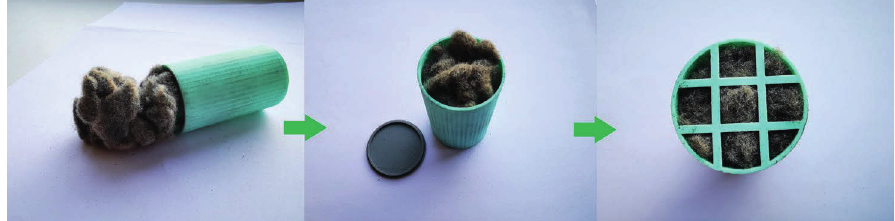
Fig. 3. Experimental measurements sample holder.